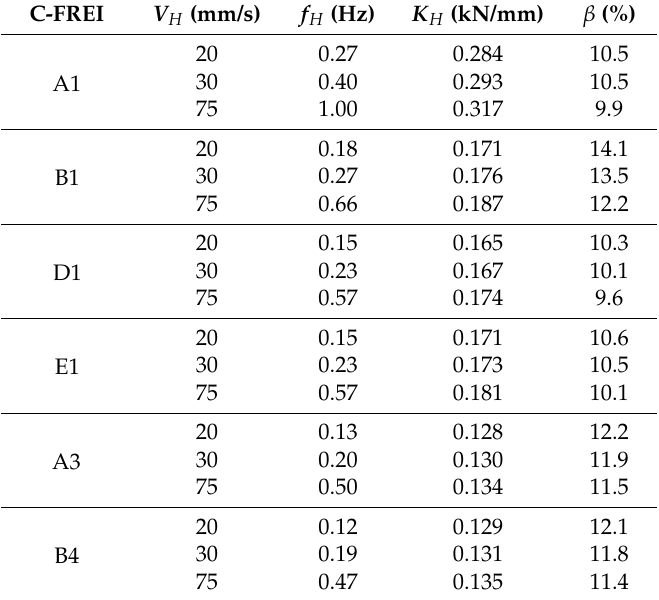
Figure 11. Effective horizontal stiffness of C-FREIs under different lateral cyclic rates (20, 30, and 75 mm/s) at 50% shear strain.